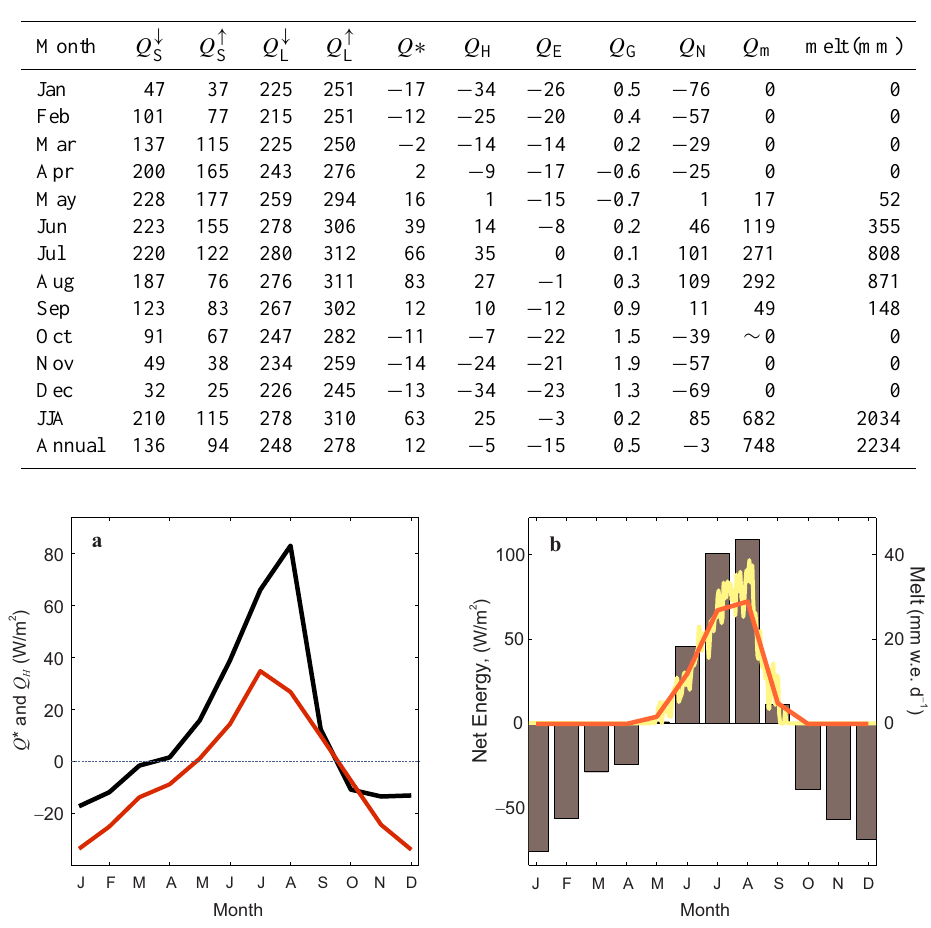
Table 5. Mean monthly surface energy balance at the Haig Glacier AWS, 2002–2012. Radiation fluxes are measured. Turbulent and conduc- tive heat fluxes are modelled. All fluxes are in Wm − 2 except for the monthly melt energy Q m , in MJm − 2 . Melt is the total monthly melt (mmw.e.).